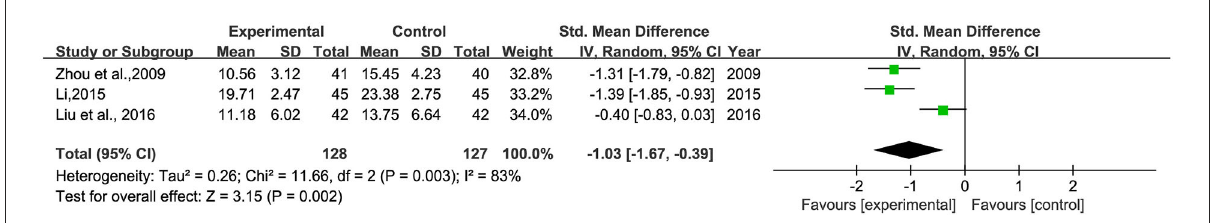
FIGURE7 Meta-analysis of BHD and antidepressants regarding neurological deficit scores. Green: Continuous.